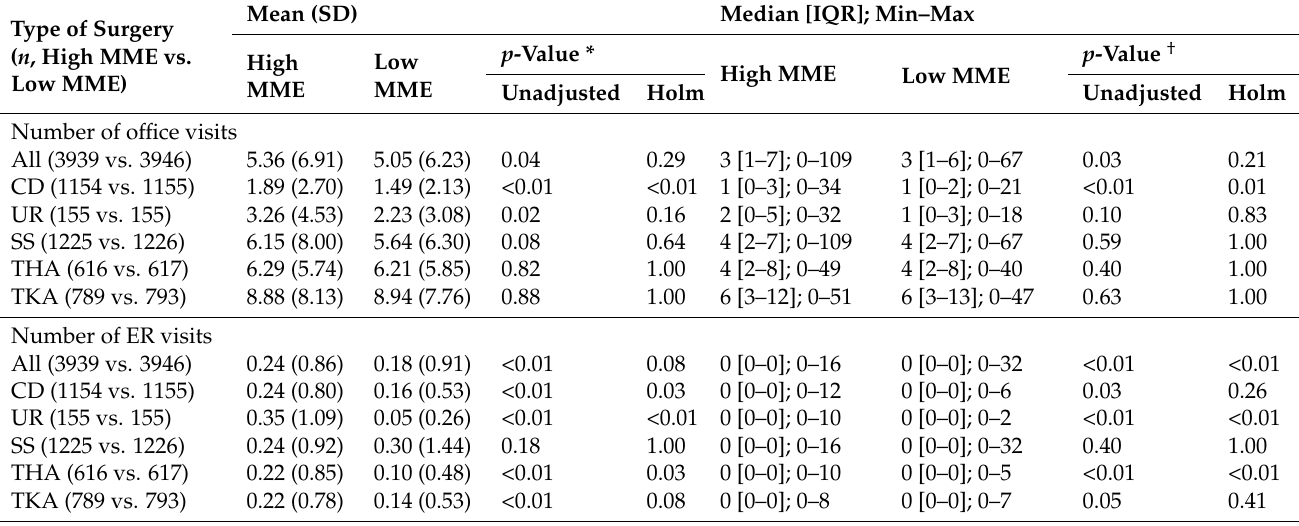
Table 5. Healthcare resource utilization: number of office visits and ED visits during 180-day post- discharge period and number of telephone encounters during 7-day post discharge